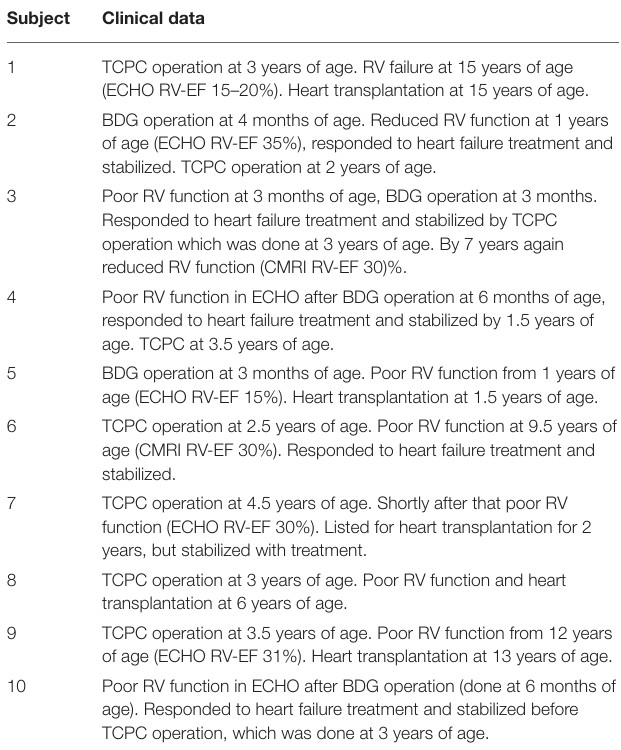
TABLE 1 | Clinical characteristics of HLHS study